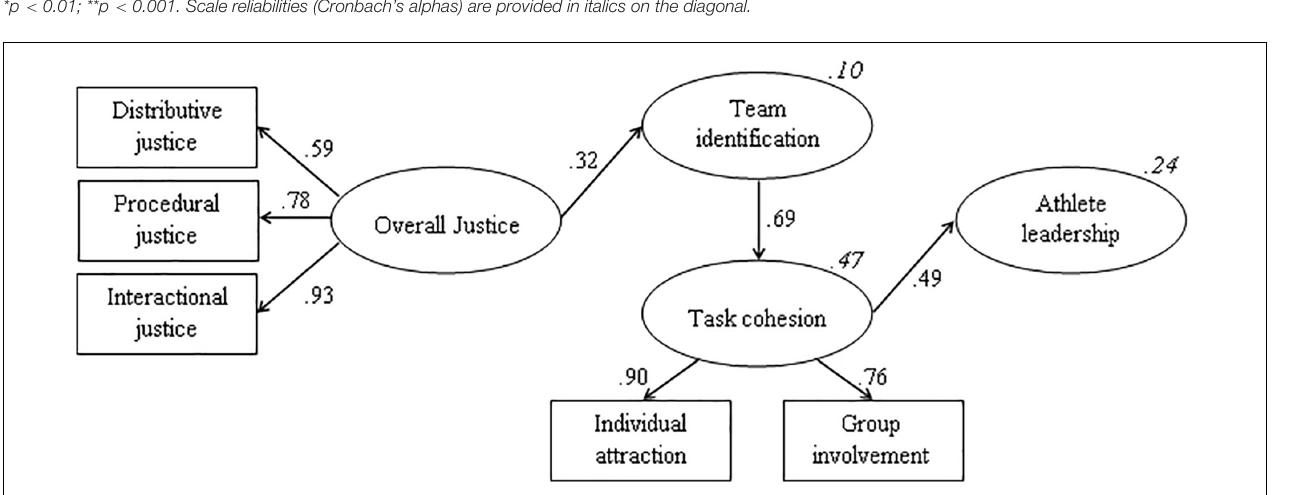
FIGURE 2 | The structural model of overall justice, team identification, task cohesion, and athlete leadership quality with the regression coefficients and the proportions explained variance. All coefficients presented are standardized and significant ( p ≤ 0.001).